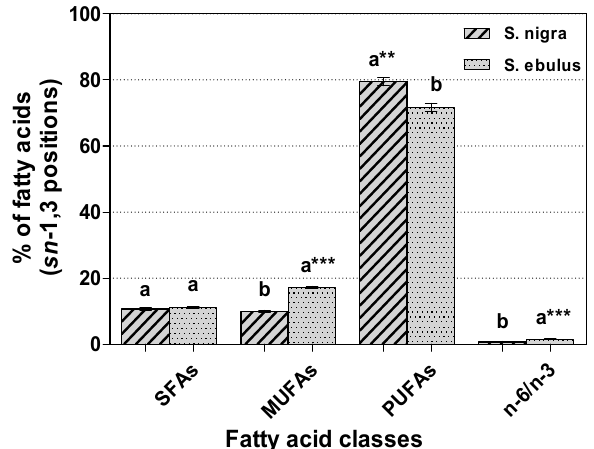
Figure 2. Positional distribution (%, means ± standard deviation, n = 3 × 3) of fatty acid classes in the TAGs sn -1, 3 positions of Sambucus seed oils.